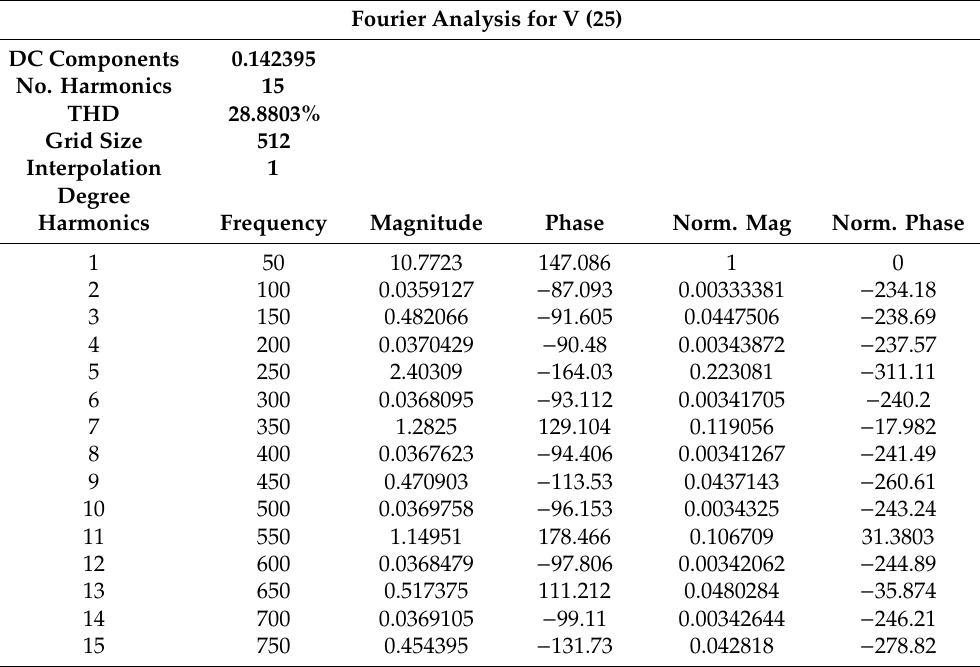
Table 9. Total harmonic distortion (THD). Fourier Analysis for V (25)